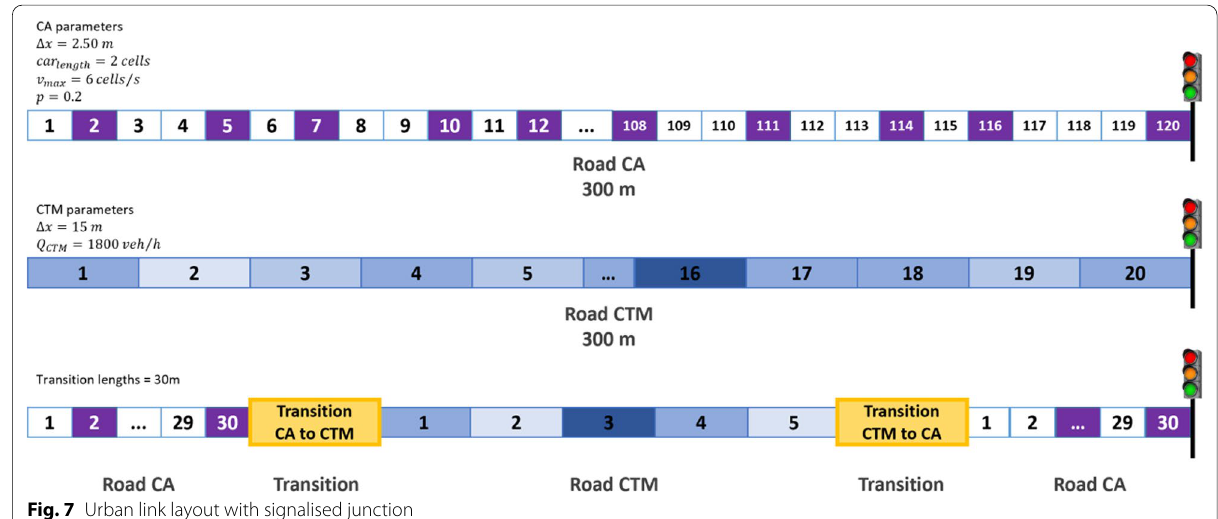
Fig. 7 Urban link layout with signalised junction